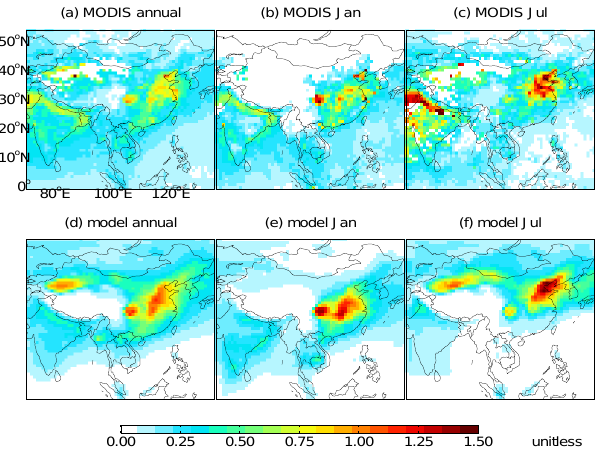
Figure 3. Aerosol optical depth (AOD) over East Asia from MODIS for (a) 2010 annual mean, (b) January, and (c) July, and from the GEOS-Chem model: (d) annual mean, (e) January, and (f) July.